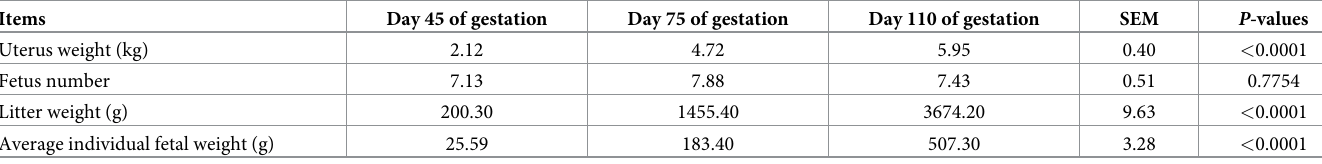
Table 2. The reproductive performance of sows at different gestation period (n =